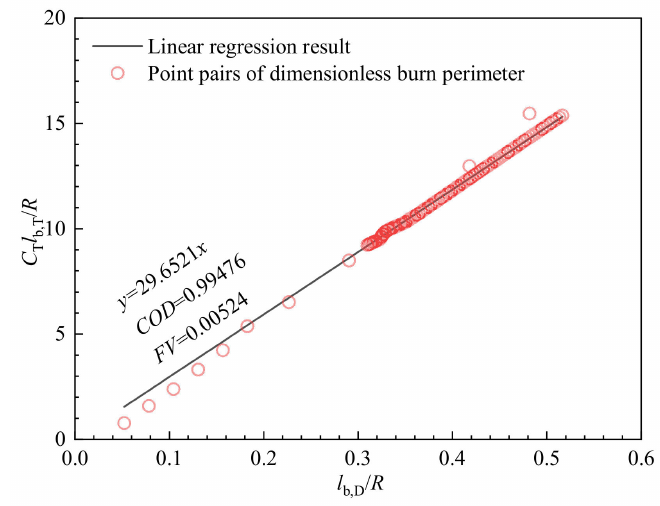
Figure 19. Linear regression to evaluate the performance-matching degree of the star grain.